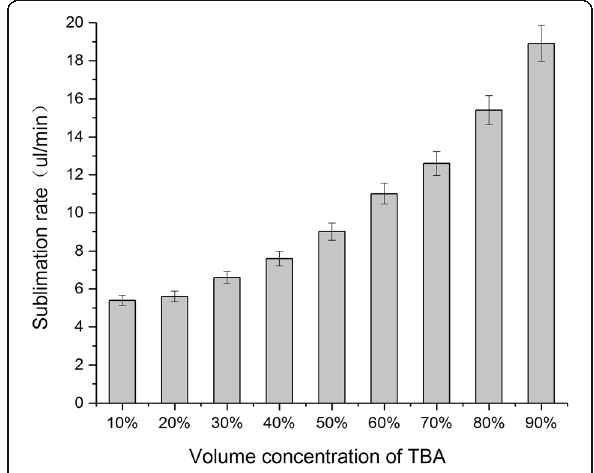
Fig. 3 Sublimation rate of TBA/water co-solvent with different volume percentage (mean ± SD, n =